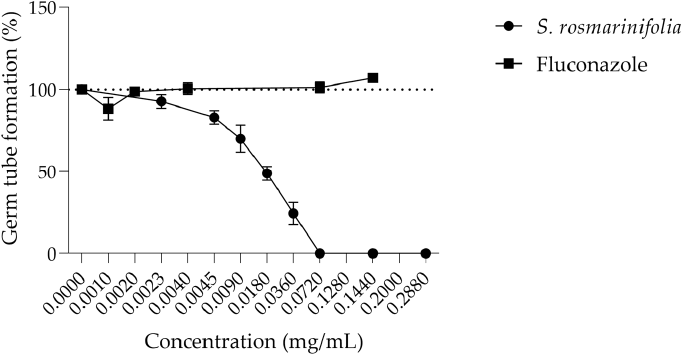
Figure 1. Effect of S. rosmarinifolia essential oil on germ tube formation of C. albicans ATCC 10231. Results show the mean ± SD of three independent assays made in